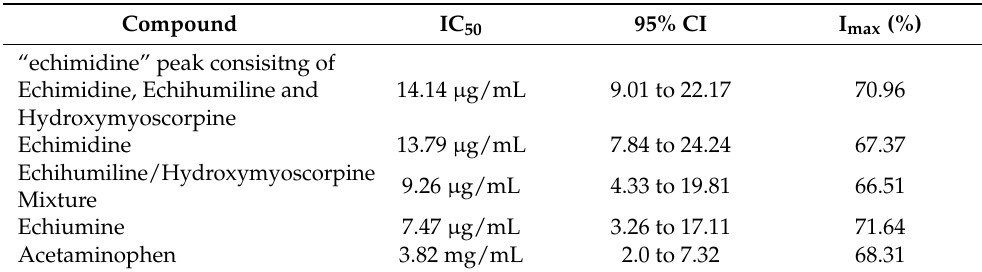
Table 2. Mean IC 50 and maximal inhibitions values on cell viability in primary culture hepatocytes for different